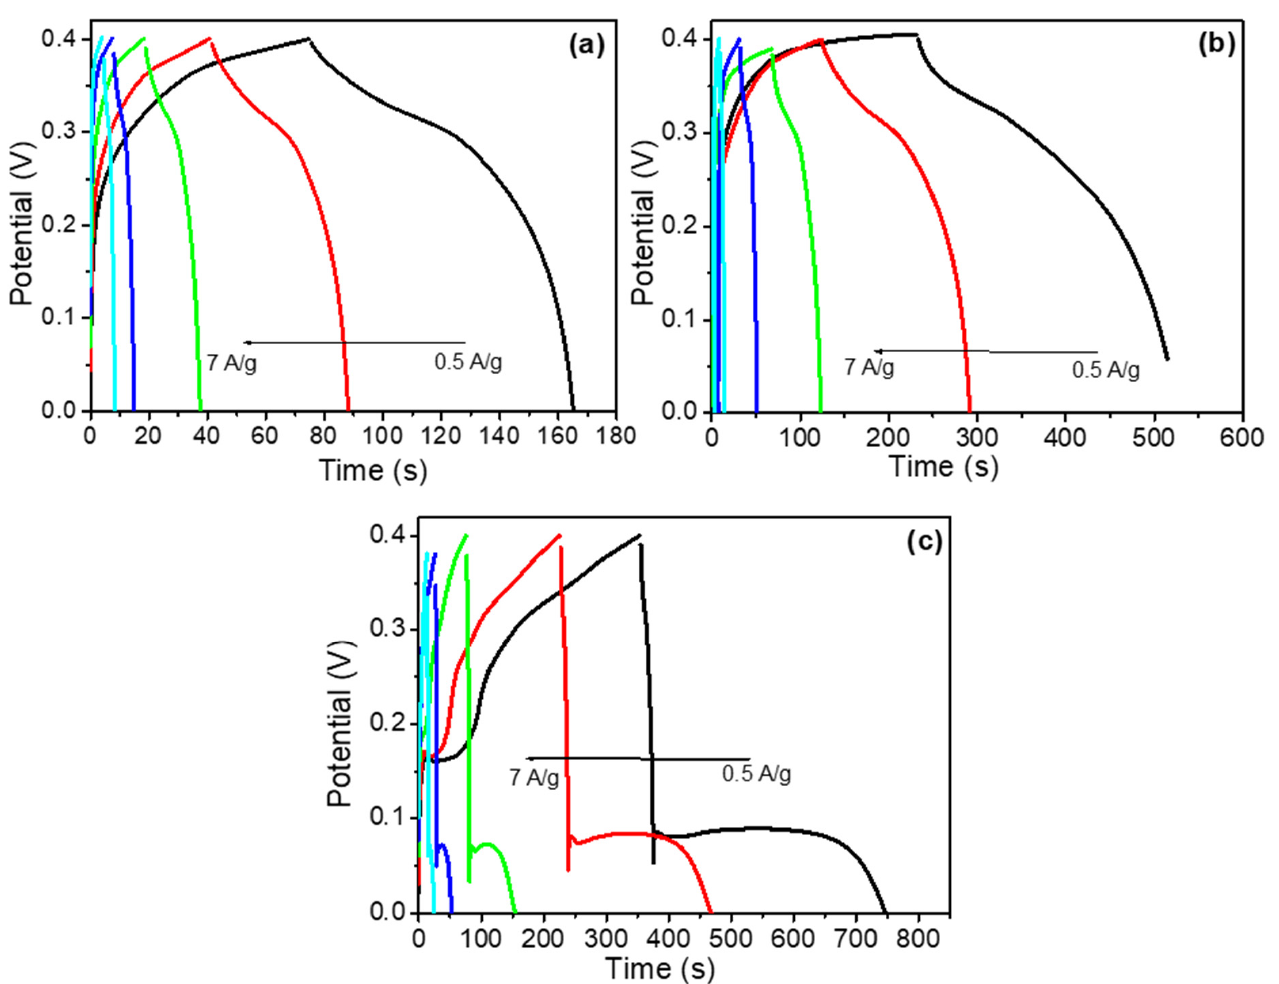
Figure 9. ( a ) GCD curve of pure CuO nanosheets, ( b ) rGO@CuO and ( c ) Ag-rGO@CuO nanocomposites at different current loads.